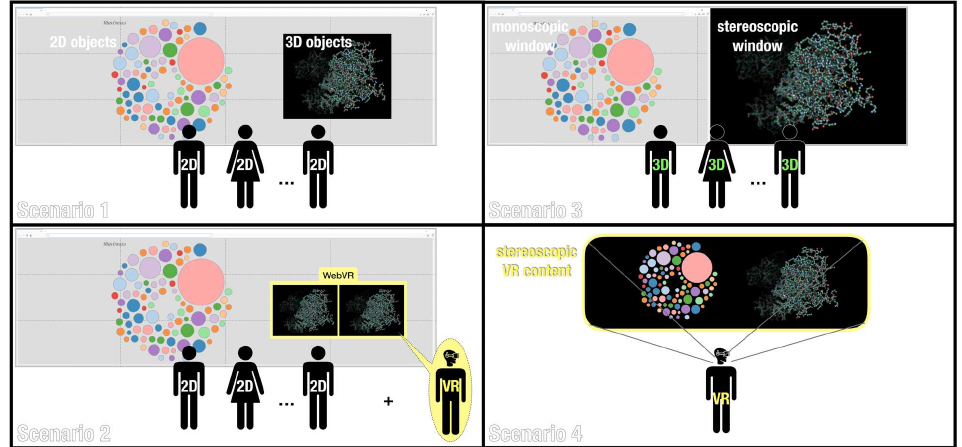
Figure 7: Schematic depiction of four possible visualization scenarios. The way UnityMol is integrated with MinOmics for direct visual feedback using our wall-sized display and VR headsets determines the stereoscopic features and envi- ronments accessible to MinOmics users, ranging from pure monoscopic (scenario 1) to fully immersive VR (scenario 4)